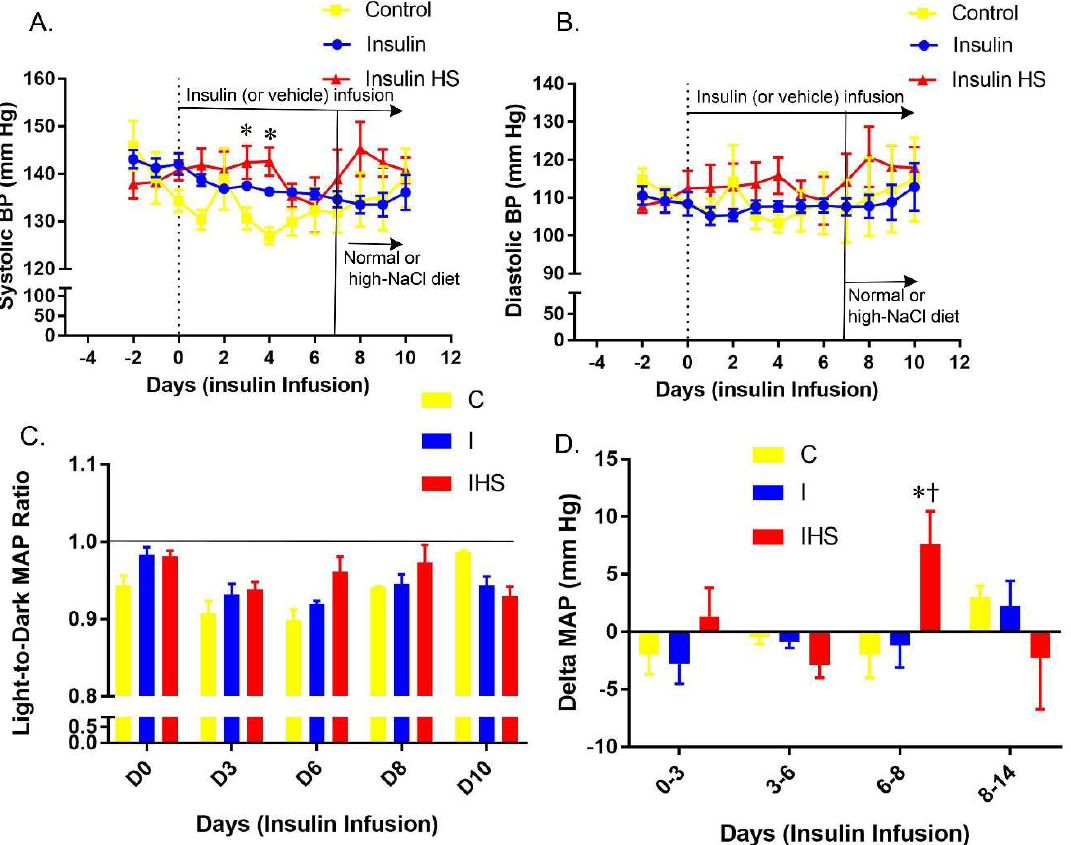
Figure 1. Blood pressure—Daily mean ( A ) systolic and ( B ) diastolic blood pressures in control (vehicle infused, 1% NaCl diet), insulin infused (fed 1% NaCl all study) and insulin infused plus high-NaCl diet (4%, high NaCl second week,) treated mice; ( C ) light-to-dark period mean arterial pressure (MAP) ratio on various days; ( D ) delta (change) in mean arterial pressure (MAP) in various periods; (mean ± sem, n = 4–7/group); * indicates a significant difference from control and † from insulin-treated, by multiple comparisons testing following a significant one-way analysis of variance (ANOVA, p < 0.05).